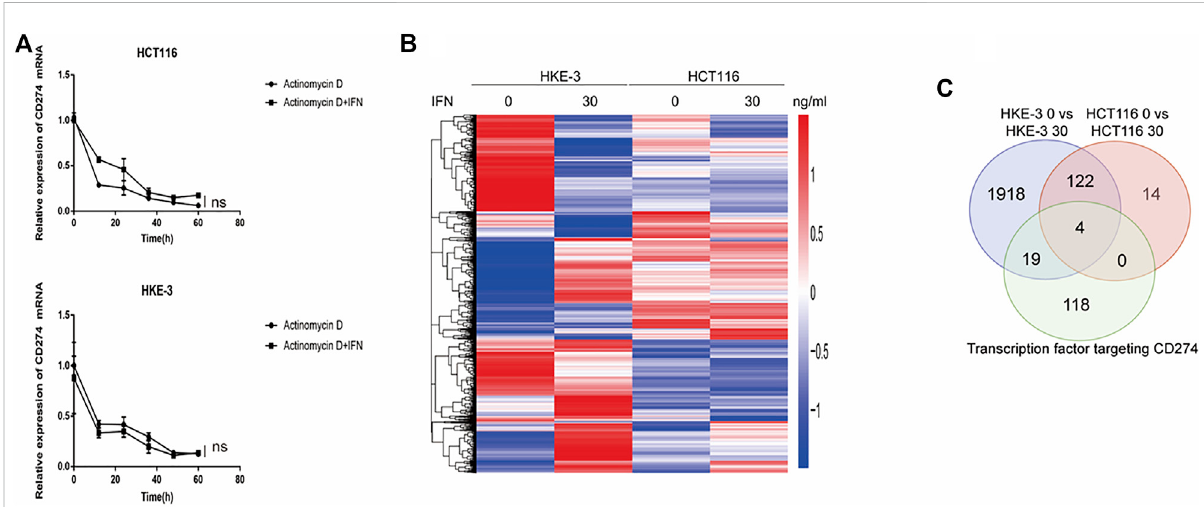
FIGURE 4 (A) Actinomycin D Chase experiments to investigate the effect of IFN- γ on mRNA half-lives in HCT116 and HKE-3 cells. (B) Hierarchical clustering of the differentially expressed genes under each experimental condition. Each column represents a sample, and each row represents a gene. The red and blue gradients indicate an increase and a decrease in gene expression abundance, respectively (Liu et al., 2018). (C) Venn diagram analysis showing the number of transcription factors targeting the PD-L1 promoter that can be affected by IFN- γ in HCT116 and HKE-3